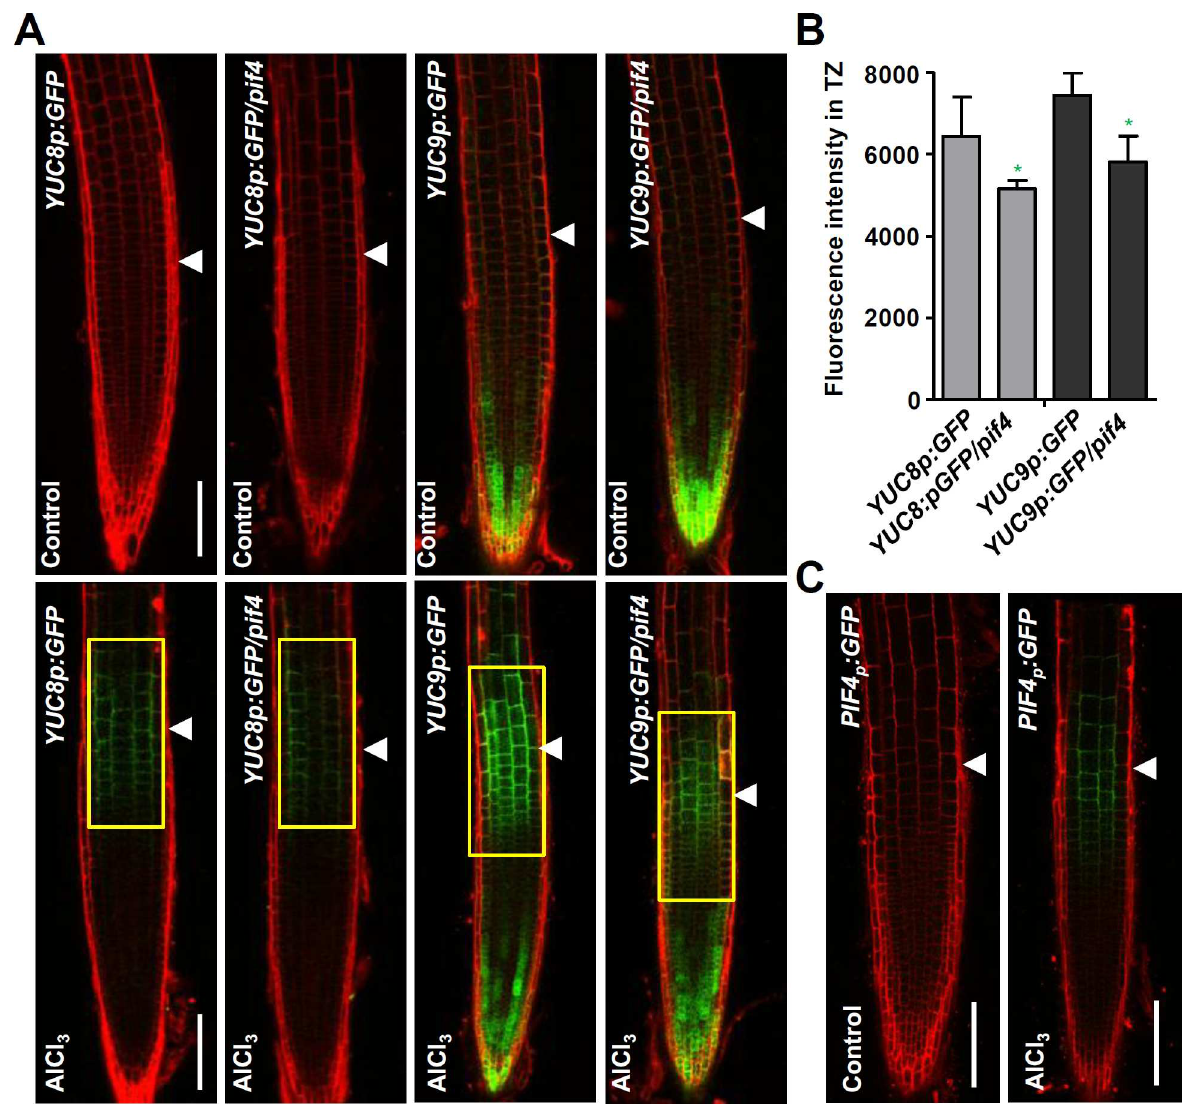
Fig 9. Al regulated local induction of YUCs in root-apex TZ is regulated by PIF4. (A) Five-day old YUC8p : eGFP-GUS , YUC8p : eGFP-GUS/pif4-101 , YUC9p : eGFP-GUS , YUC9p : eGFP-GUS/pif4101 transgeneswere exposed or not (control) to 25 μ M AlCl 3 for two hours. Cell boundaries appear red followingpropidium iodide staining. The TZ is marked by white arrowheads. Scale bar: 100 μ m. (B) Quantification of the Al-induced fluorescence intensity in the TZ of YUC8p : eGFP-GUS , YUC8p : eGFP-GUS/pif4-101 , YUC9p : eGFP-GUS , YUC9p : eGFP-GUS/pif4-101 seedlings.The detected fluorescence region in TZ is marked by yellow rectangles. Cell boundaries appear red followingpropidiumiodide staining. Error bars indicate mean ± SD (n (cid:21) 20). Statistical difference from detected fluorescence is indicatedby asterisks (Fisher’s exact test, * P < 0.05). (C) The expression of PIF4p : GFP transgenesin the root-apex epidermis in presence of 25 μ M AlCl 3 for 2 hours. Cell boundaries appear red followingpropidiumiodide staining. The TZ is marked by white arrowheads.Scale bar: 100 μ